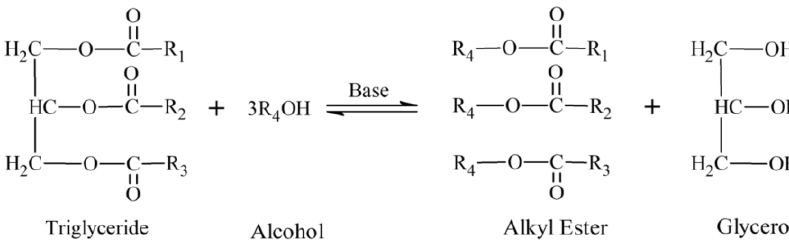
Figure 2. Overall transesterification reaction of biodiesel production.